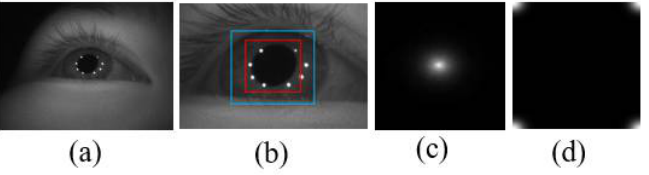
Figure 4. Initialization process. ( a ) The original image. ( b ) The image near the pupil; the red and blue rectangles represent the detected pupil image and the pupil image used for tracking, respectively. ( c ) A standard response map. ( d ) The initial correlation filter obtained from learning.